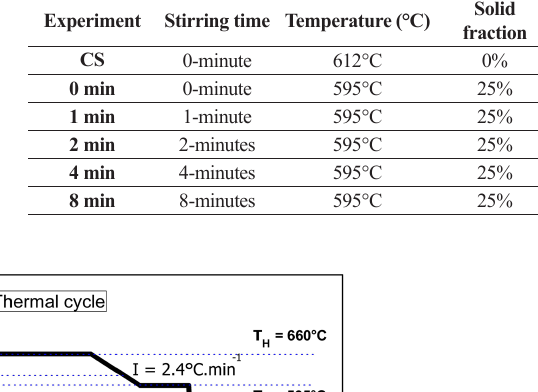
-Room temperature. (I) Slow cooling. (II) Rapid a